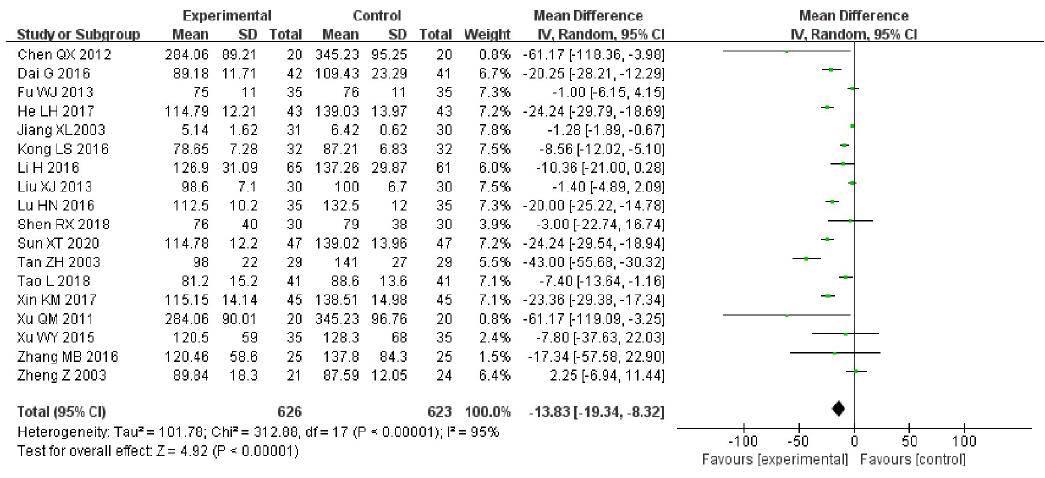
Fig 5. Forest plot for